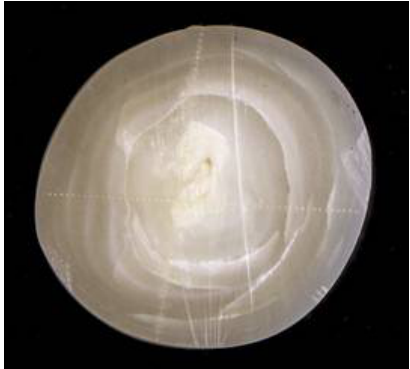
Figure 30. Unpolished surface of the top cross-section sample with two perpendicular lines of spot analyzed by LA-ICP-MS analysis.